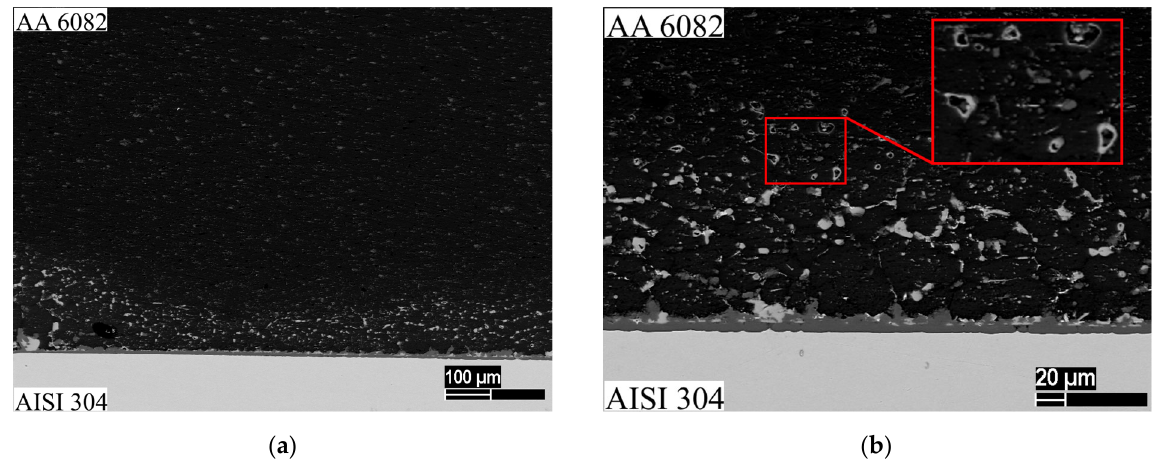
Figure 11. Microstructure of the AISI 304/AA6082 joint brazed according to the 540 °C/30 min mode obtained by SEM at different magnifications: ( a ) 100× magnification; ( b ) 500× magnification.